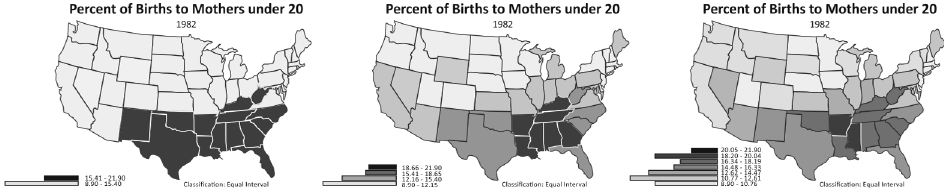
Fig. 5. Example of a non-temporal animation (selected frames) presenting how the number of choropleth map intervals affects the image of a phenomenon